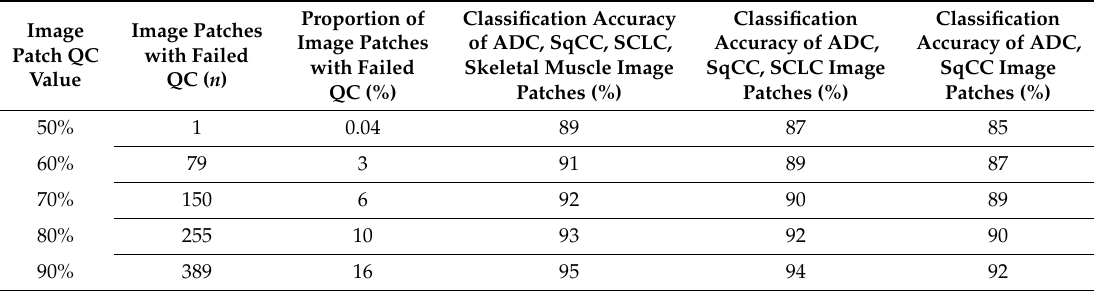
Table 3. Proportion of image patches with failed QC and classification accuracy according to image patch QC.